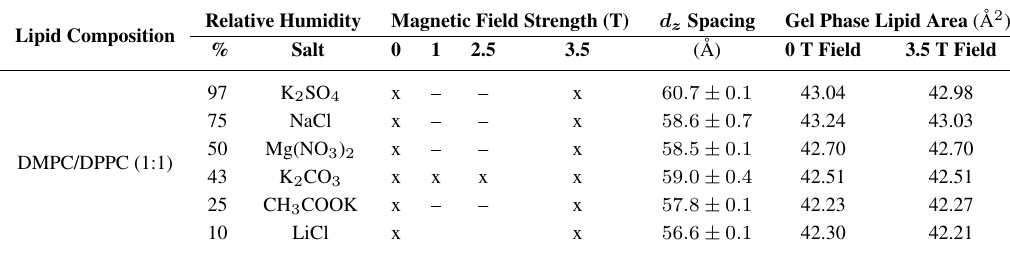
Table 1. List of all samples prepared for this study. All scans were measured at a temperature of T = 30 ◦ C (303 K). Different relative humidities were achieved through saturated salt solutions. Lamellar d spacings and lipid area of the gel state patches were determined from z out-of-plane and in-plane diffraction,